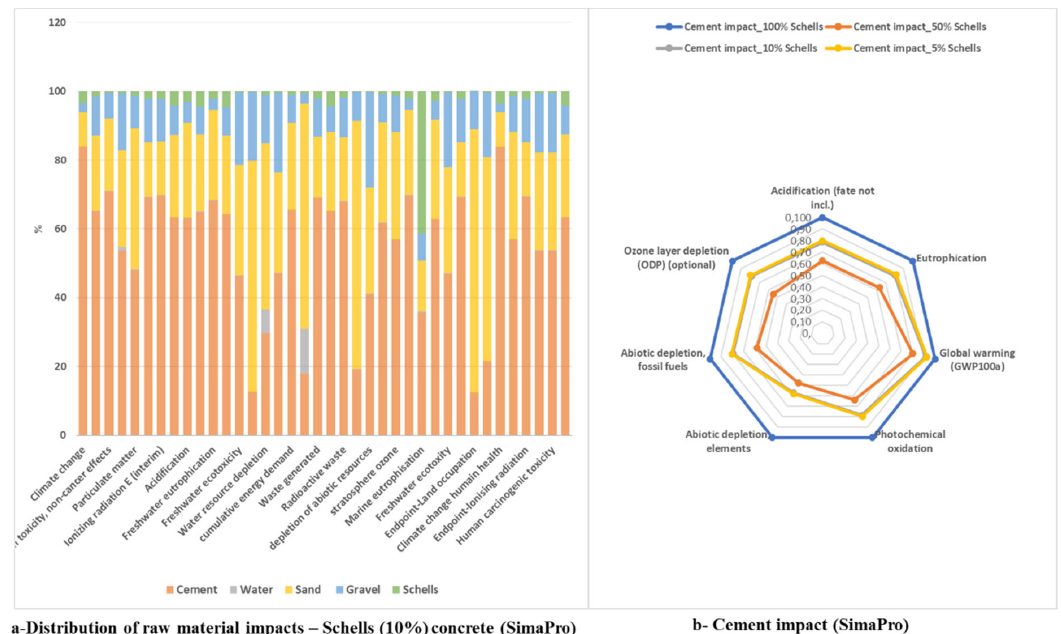
Figure 12. Environmental impact. ( a ) Distribution of raw material impacts and ( b ) Cement impact.